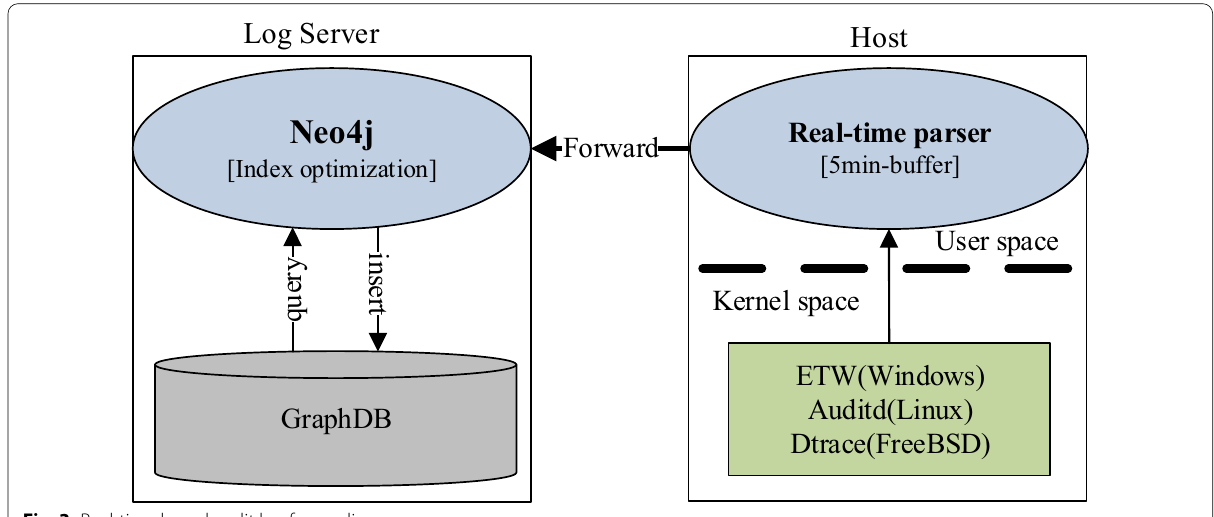
Fig. 3 Real-time kernel audit log